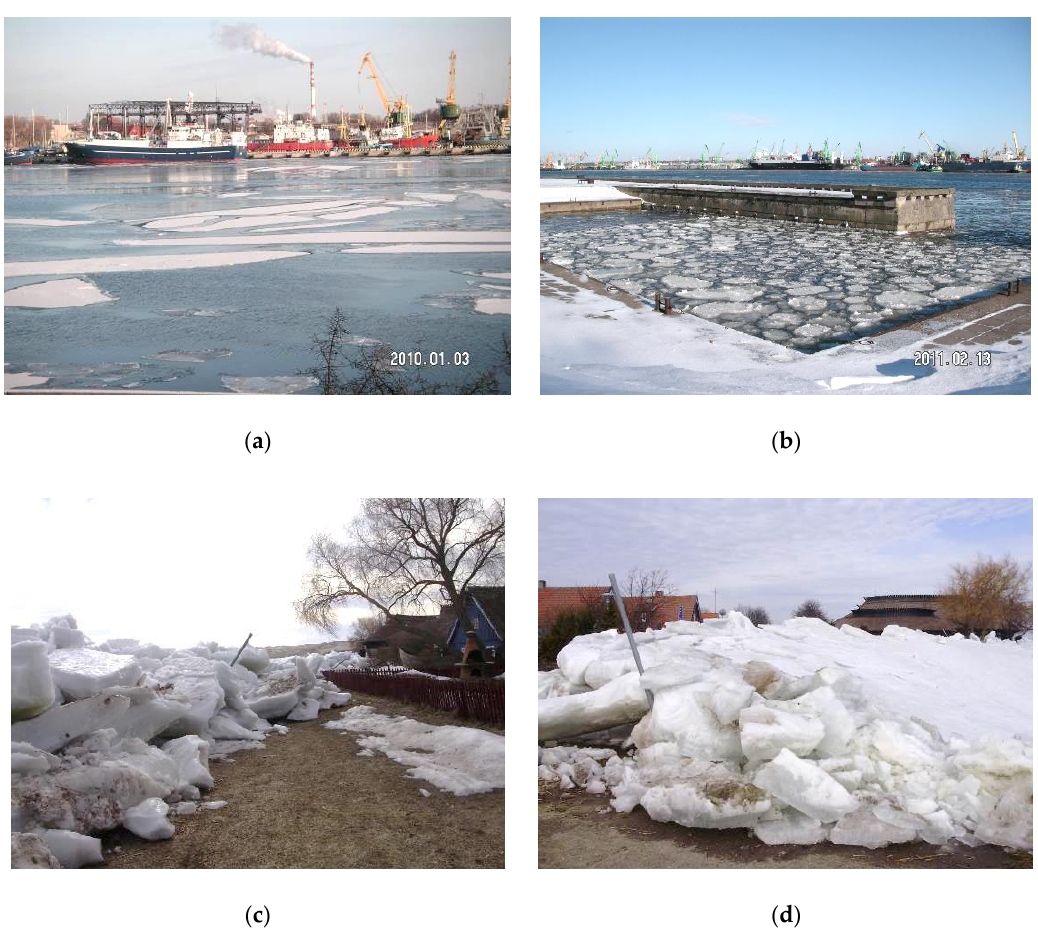
Figure 3. Photographs illustrating the ice conditions in the Klaipėda Strait taken on: ( a ) 3 January 2010 and ( b ) 13 February 2011; and ( c , d ) heavy ice accumulation along the coasts of Nida on 17 March 2011. Photographs taken by I. Dailidienė and I. Kairytė. The temporal variability of ice extent in the CL and the SEB during four winter seasons in 2009– 2013 is shown in Figure 4, while a more detailed analysis of ice cover changes in relation to air temperature and wind conditions is presented below.